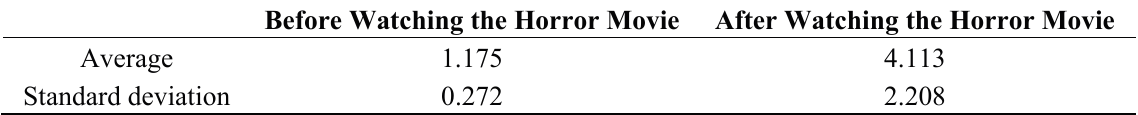
Figure 13. Comparison of subjective evaluation scores before and after watching the horror movie. Table 4. Average value and standard deviation of subjective evaluation scores.